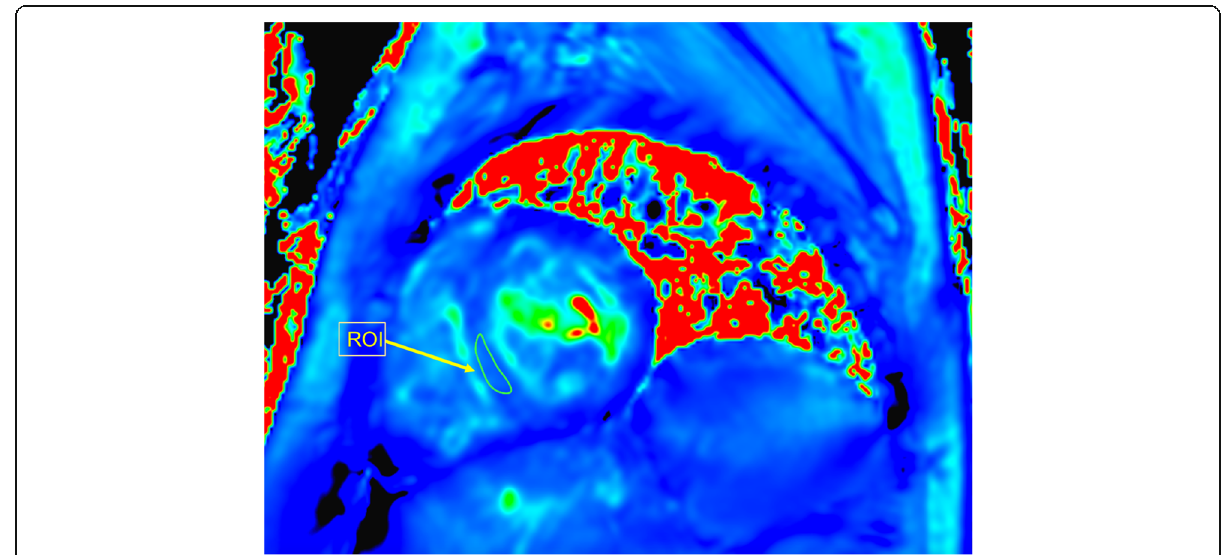
Fig. 1 T2* map with a region of interest (ROI) placed in the interventricular septum